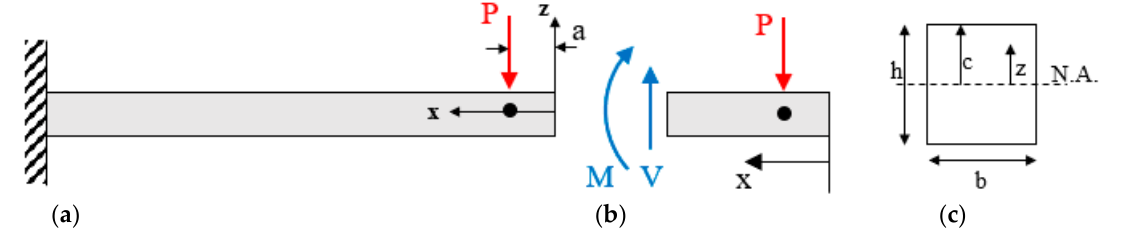
Figure 1. ( a ) Cantilevered beam with an applied tip load P and its ( b ) free-body diagram illustrating the internal bending moment M and shear V and ( c ) the beam cross-section.